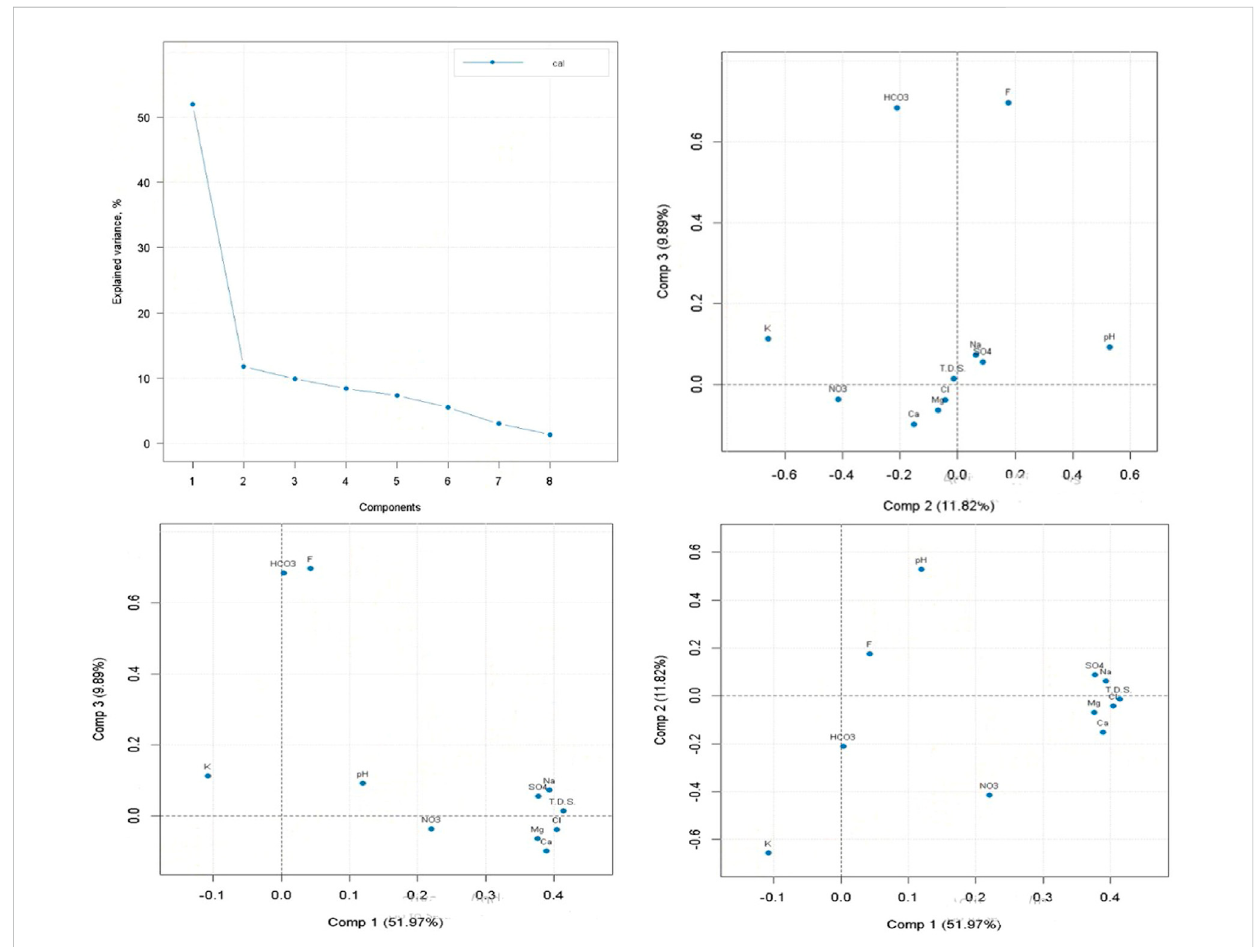
FIGURE 5 PCA components of all parameters in the groundwater of Wadi